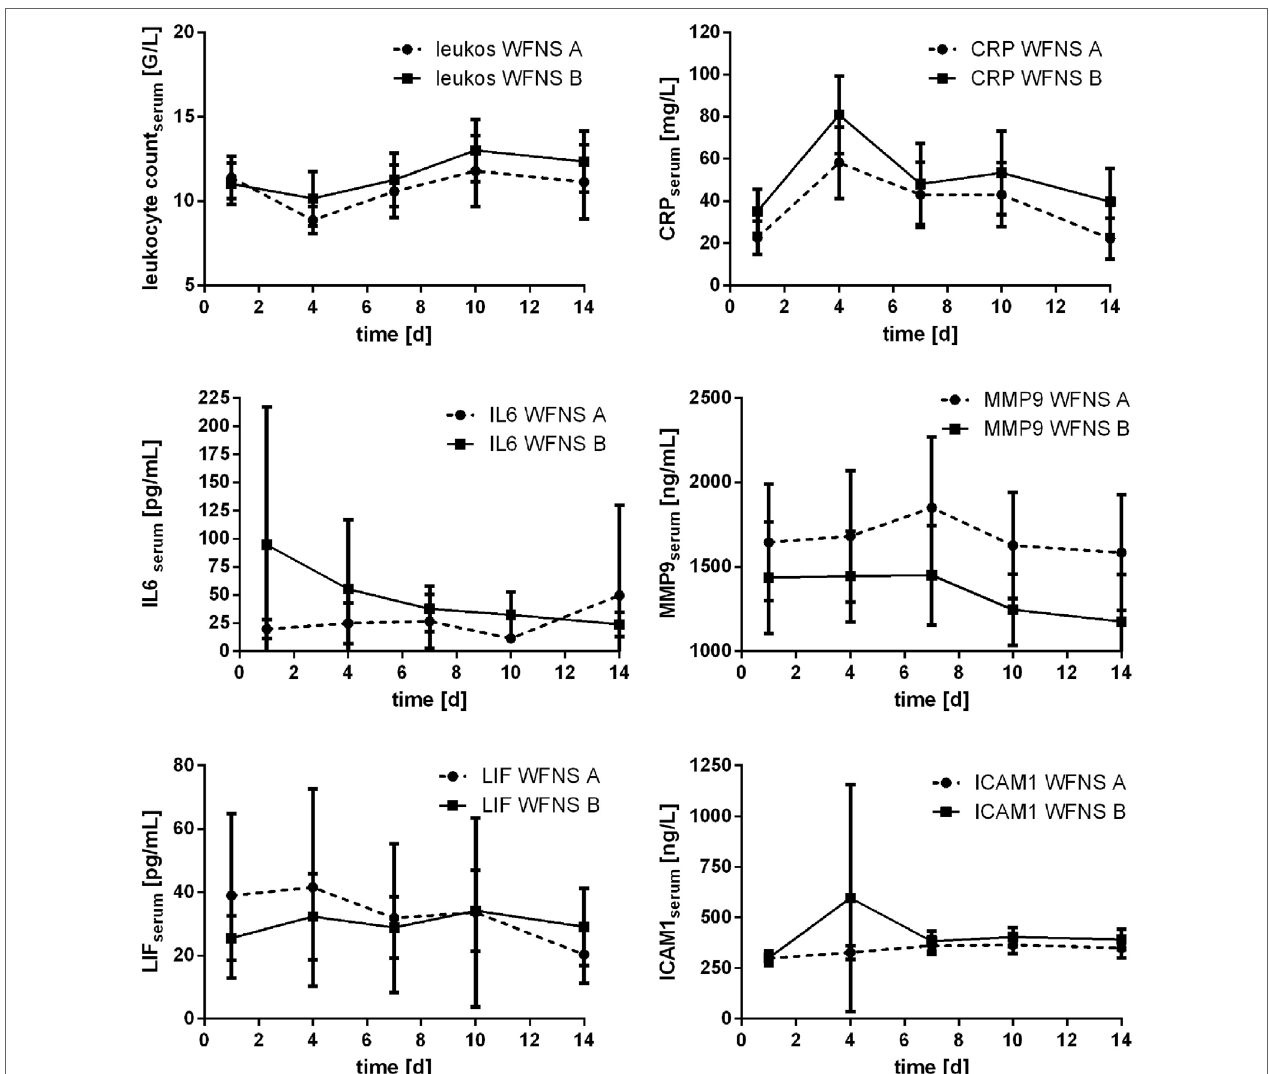
FigUre 9 | Courses of serum inflammatory parameters related to dichotomized WFNS scale score ( ± 95% confidence